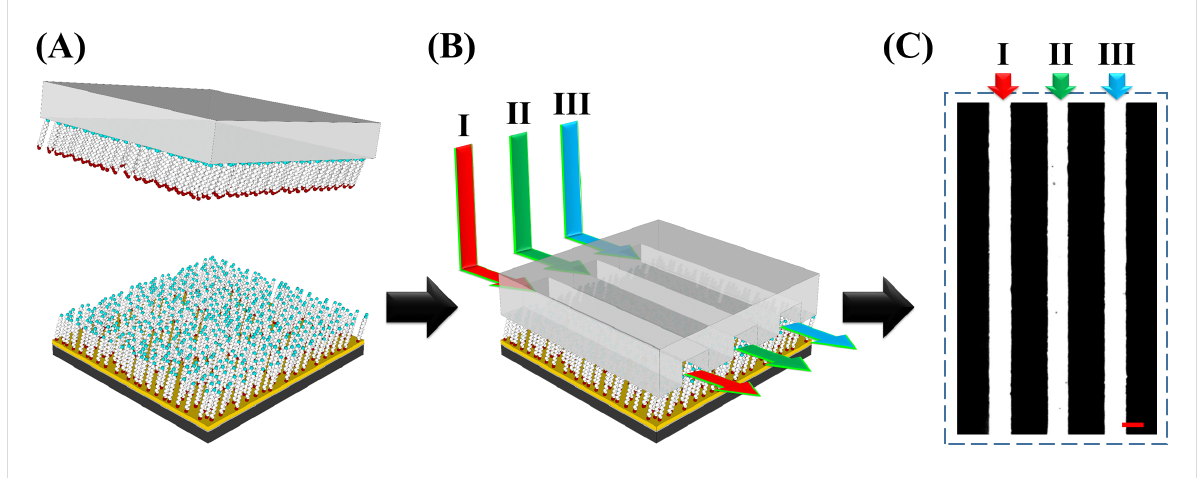
Figure 4: Schematic illustration of multiplexed bioactive surface fabrication by the combination of chemical lift-off lithography (CLL) and microfluidics: (A) CLL treatment with an activated featureless PDMS stamp. (B) Probe insertion by the combination of a microfluidic device. (C) The fluorescence image represents a multiplexed surface spatially anchored with different probes including (I) Hg 2+ -specific, (II) adenosine-specific, and (III) cocaine-specific probes. The scale bar is 20 μ m.